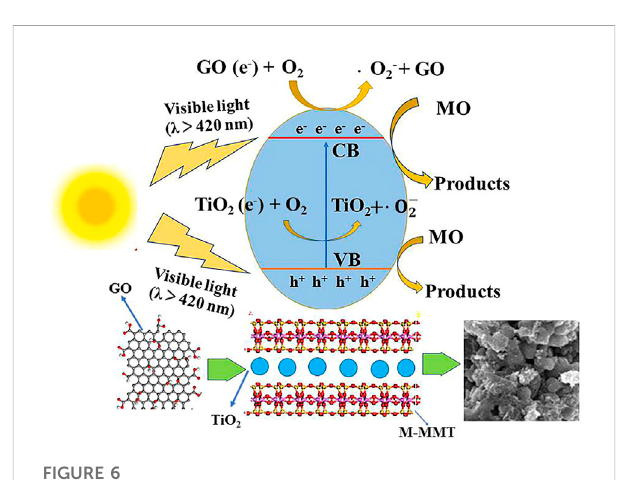
FIGURE 6 Photocatalytic degradation mechanism of MO by TiO 2 /GO/